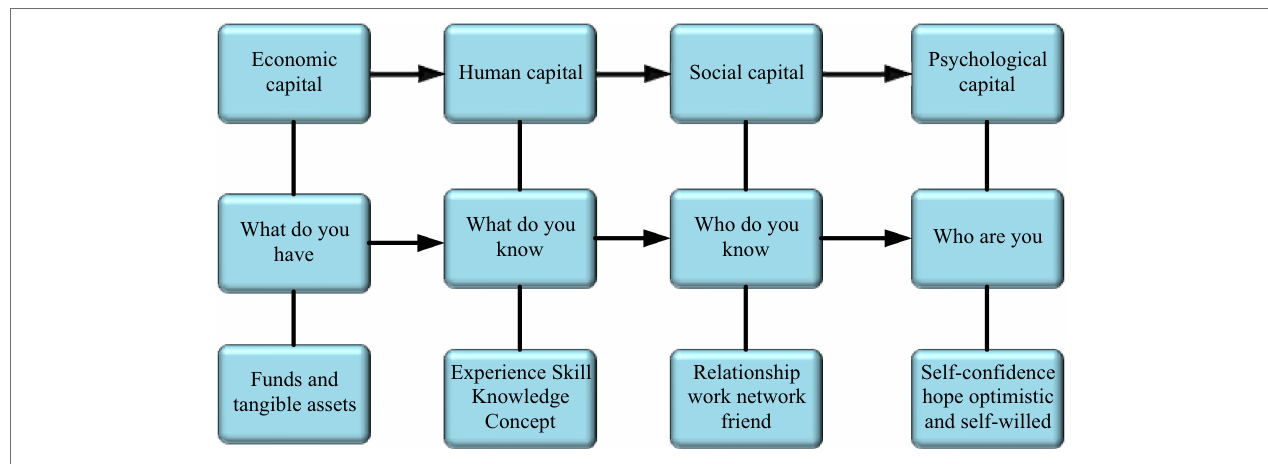
FIGURE 1 | Four major capital